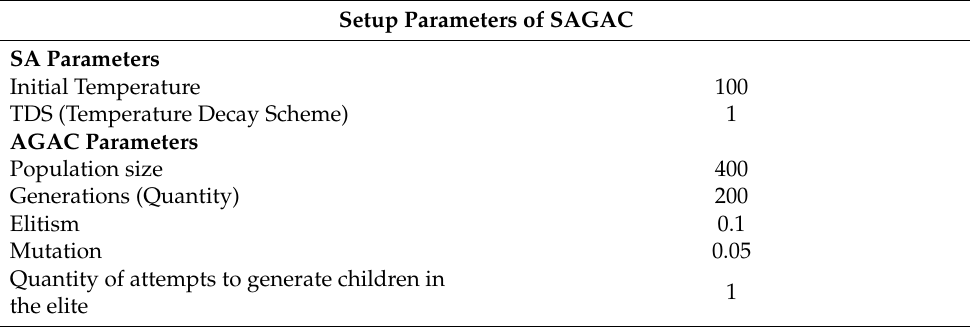
Table 4. Setup parameters of SAGAC algorithm.